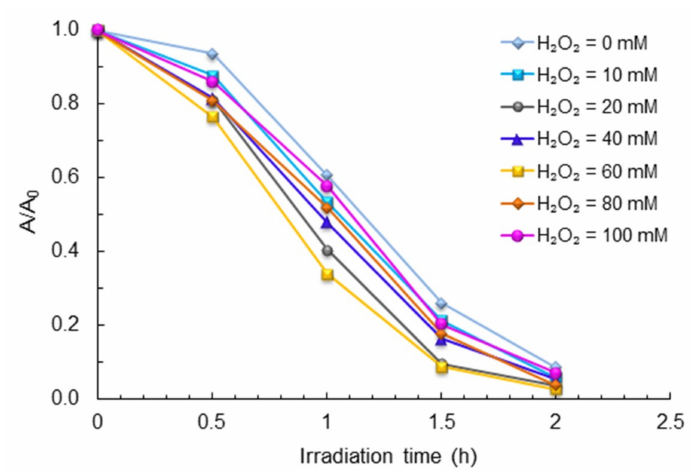
Figure 11. Photocatalytic degradation of Reactive Violet 5 (RV5) at di ff erent hydrogen peroxide concentrations (c 0 RV5 = 30 ppm; pH = 10; catalyst load = 3 g / L). A is the absorbance the dye solution at 560 nm.